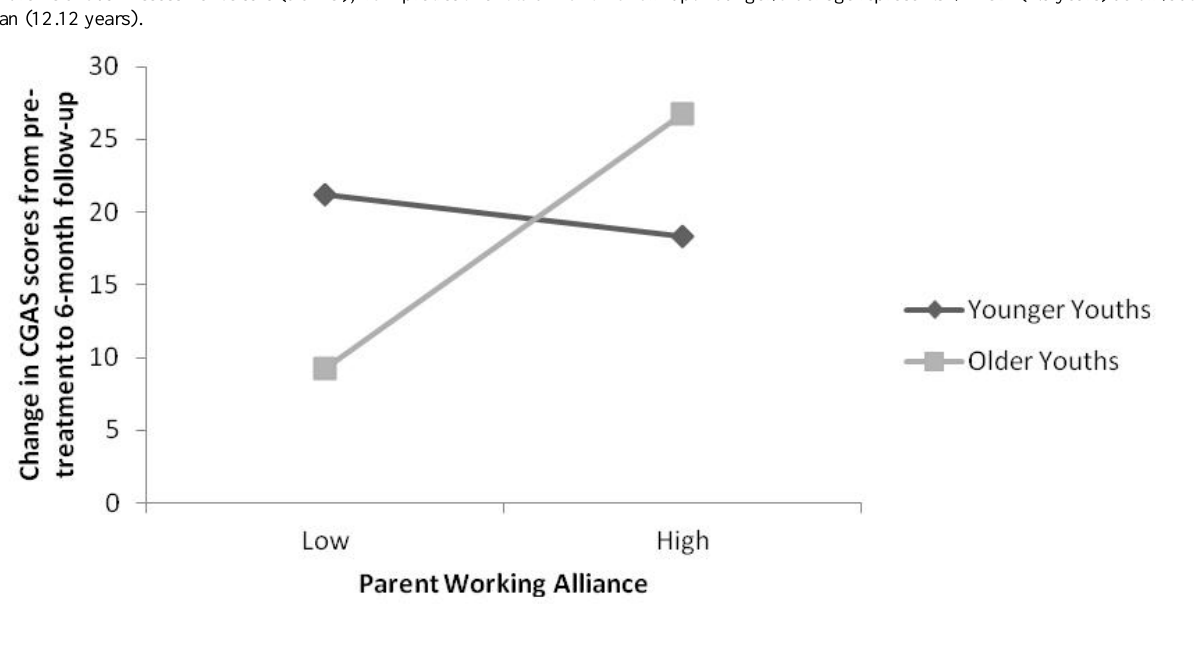
Figure 3. Conditional effects of youth age on the relationship between parent working alliance and change in child global functioning, as measured by the Children’s Global Assessment Scale (CGAS), from pretreatment to 6-month follow-up. Younger/older age represents -/+1 SD (2.5 years) below/above the mean (12.12 years).